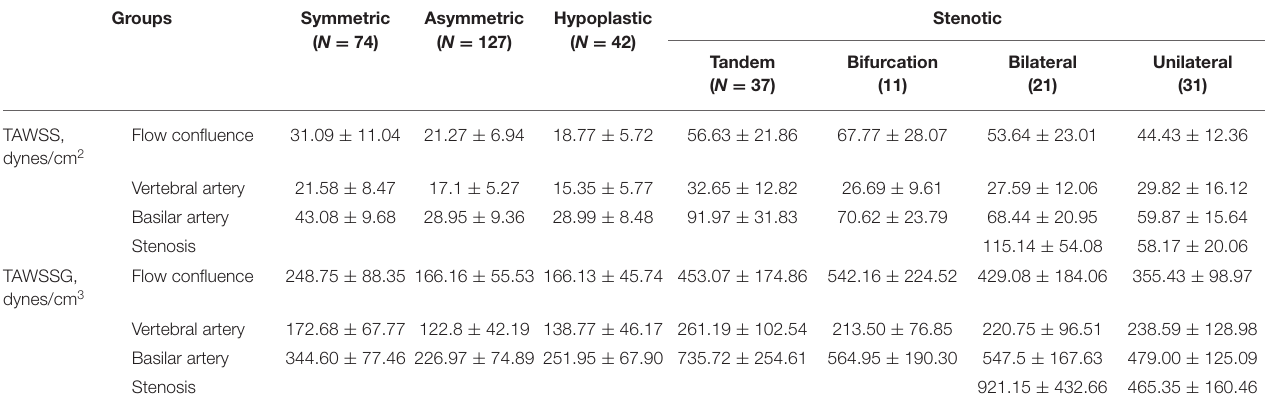
TABLE 2 | Hemodynamic parameters within intracranial vertebrobasilar arteries in symmetric, asymmetric, hypoplastic, and stenotic groups as well as unilateral, bilateral, bifurcation, and tandem stenotic sub-groups. Groups Symmetric Asymmetric Hypoplastic Stenotic ( N = 74) ( N = 127) ( N = 42) Tandem ( N =